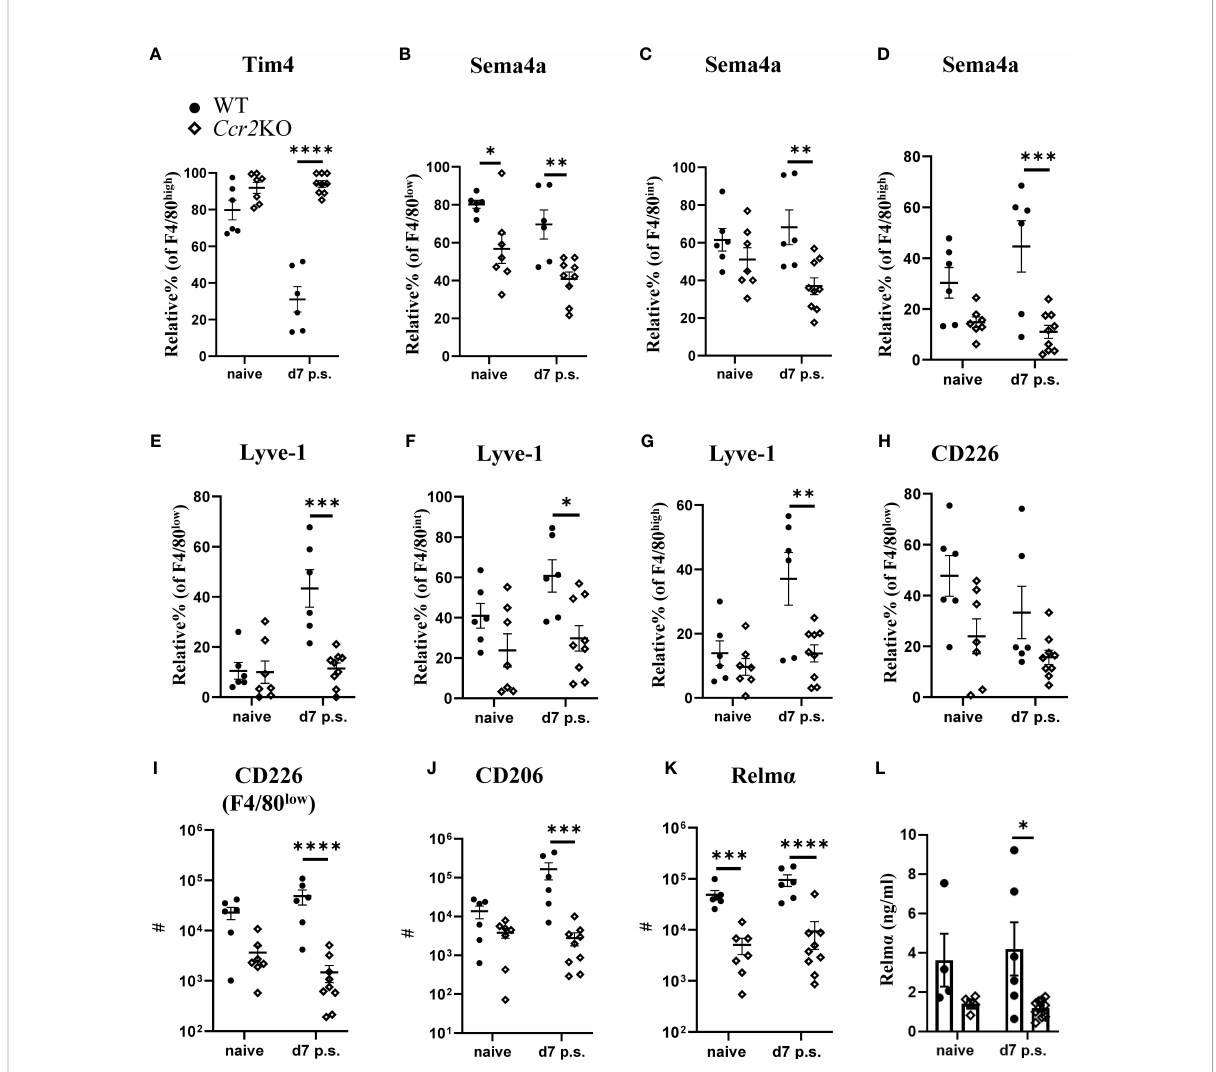
FIGURE 4 Peritoneal macrophage markers associated with monocyte-derived and intermediate subsets were altered in Ccr2- de fi cient mice. Relative % of Tim+ (A) within F4/80 high population, Relative % of Sema4a+ within F4/80 low (B) , F4/80 int (C) , and F4/80 high (D) . Relative % of Lyve1+ within F4/ 80 low (E) , F4/80 int (F) , and F4/80 high (G) . Relative % of CD226+ within F4/80 low (H) . Total number of CD226+ cells within F4/80 low subset (I) Total number of CD206+ (J) and Relm a + (K) cells within total peritoneal macrophages. Cytokine level of Relm a in peritoneal lavage (L) using ELISA. Data shows mean ± SEM, pooled from 4-5 separate experiments for naïve or 4 separate experiments for day 7, n= 4-6 mice/group; mixed male and female, * P <0.05, ** P <0.01, *** P <0.001, **** P <0.0001, ANOVA with Tukey ’ s multiple comparison